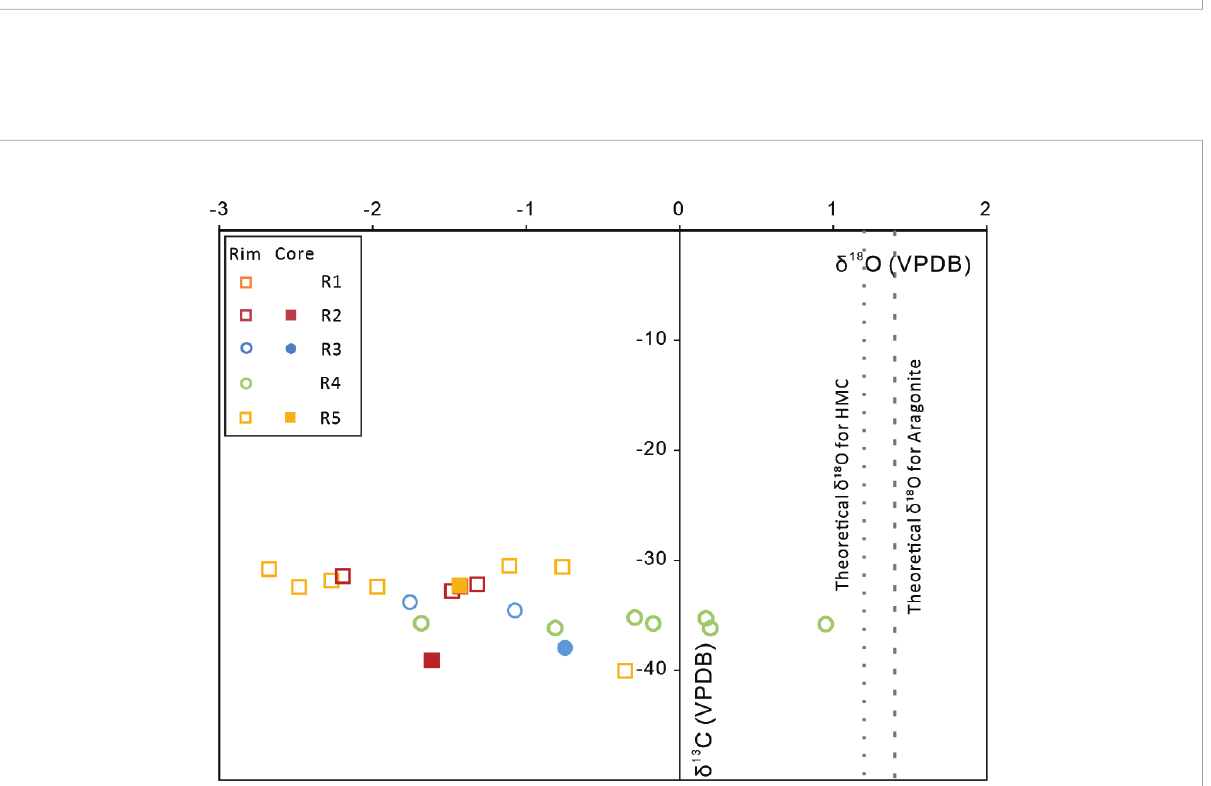
FIGURE 4 Plots of d 13 C and d 18 O values of the tubular carbonates. Dashed lines represent the theoretical d 18 O values of authigenic HMC (10 mol% MgCO 3 ) and aragonite in equilibrium with modern bottom seawater [ d 18 O value = 0 ‰ (V-SMOW); temperature = 10.8°C (Tong et al., 2013)].